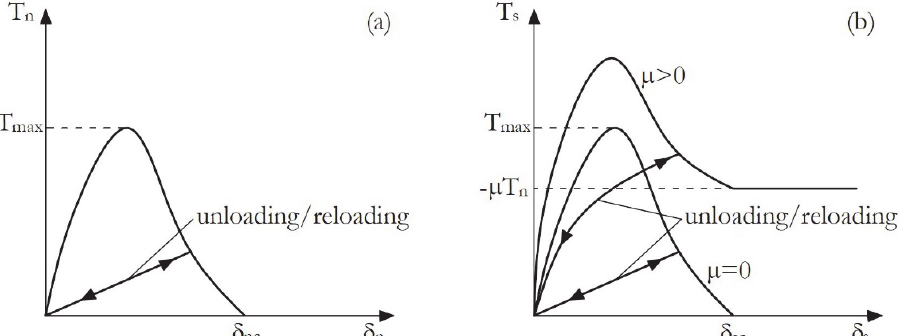
Figure 2: Mixed-mode traction-separation and contact relations in normal (a) and tangential (b) directions on a cohesive interface.